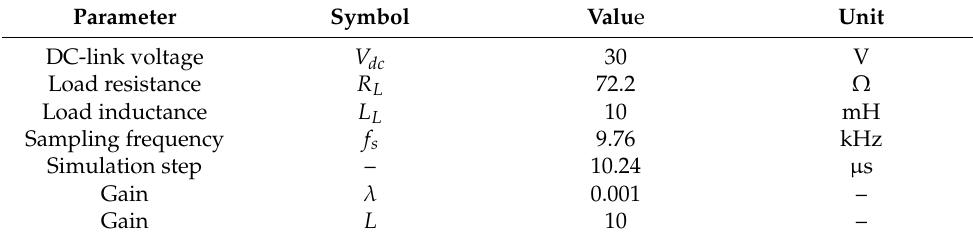
Table 2. Simulation parameter